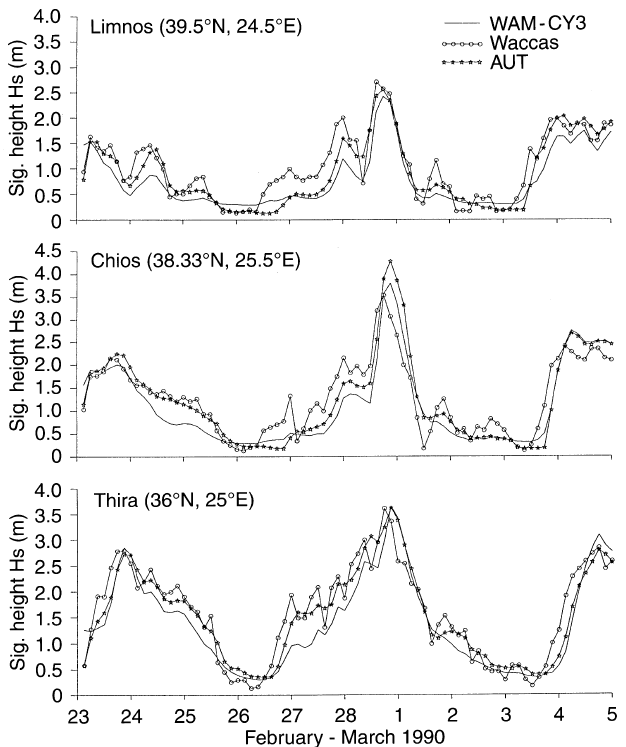
Fig. 10. Wave heights at specific grid points, February–March 1990 (WAM-cy3 v. AUT v.